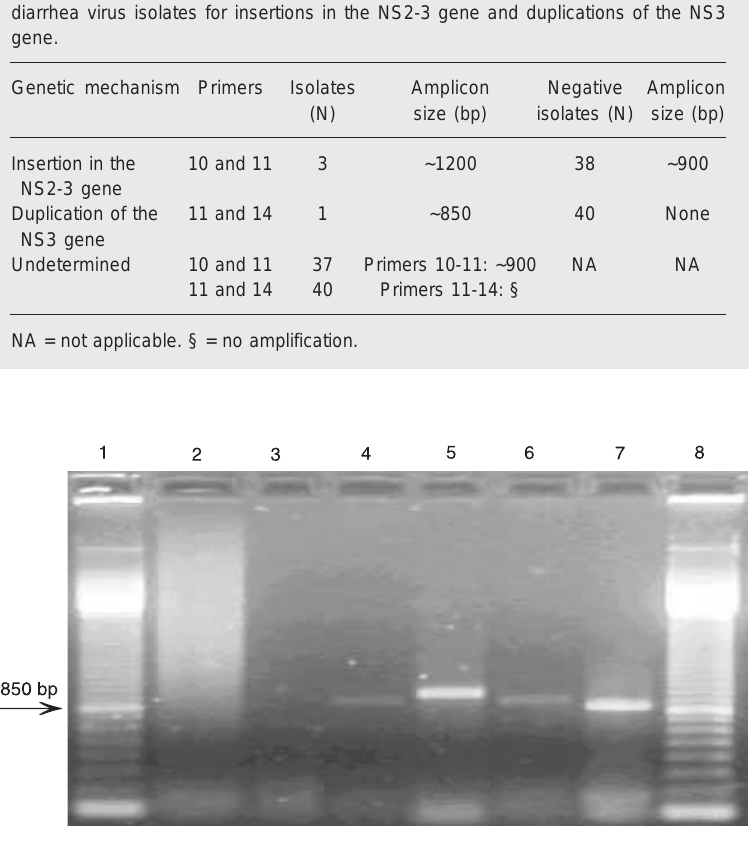
Figure 5. RT-PCR analysis for the detection of NS3 gene duplication in the genome of cytopathic bovine viral diarrhea virus (BVDV) isolates. Lane 1 , Molecular weight marker (100-bp ladder); lane 2 , negative control; lane 3 , no template; lane 4 , TGAC strain; lane 5 , TGAC strain; lane 6 , isolate 14; lane 7 , isolate 14; lane 8 , molecular weight marker. Lanes 4 and 6 show amplified products of isolates TGAC and 14 using primers 10 and 11. Lanes 5 and 7 show the amplified products of isolates TGAC and 14 using primers 11 and 14. RT- PCR products were submitted to 1% agarose gel electrophoresis, stained with ethidium bromide, and visualized under UV light. The size of the amplified products from the isolate containing duplication is indicated by